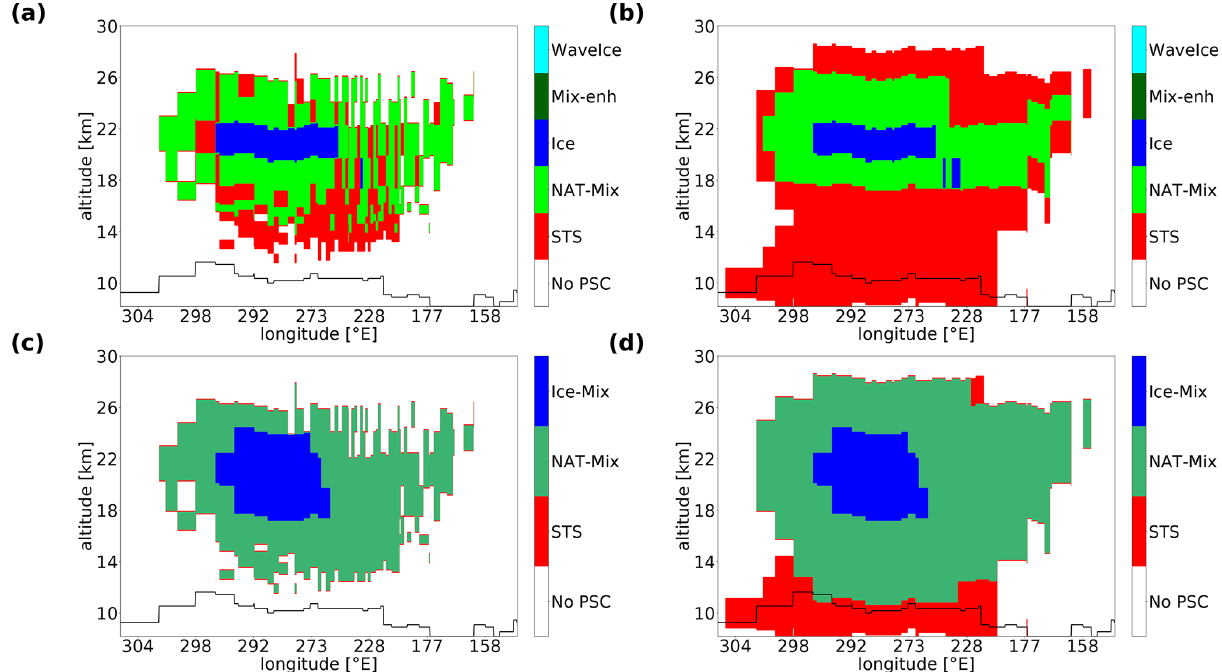
Figure A1. Composition of simulated PSCs along CALIPSO orbit 2 on 1 July 2007 according to the classification scheme from Pitts et al. (2018) after (a) and before (b) applying detection limits and instrument uncertainty. Panels (c) and (d) show the modeled PSC type (STS: STS occurrence only; NAT-Mix: NAT but no ice occurrence; Ice-Mix: ice occurrence).